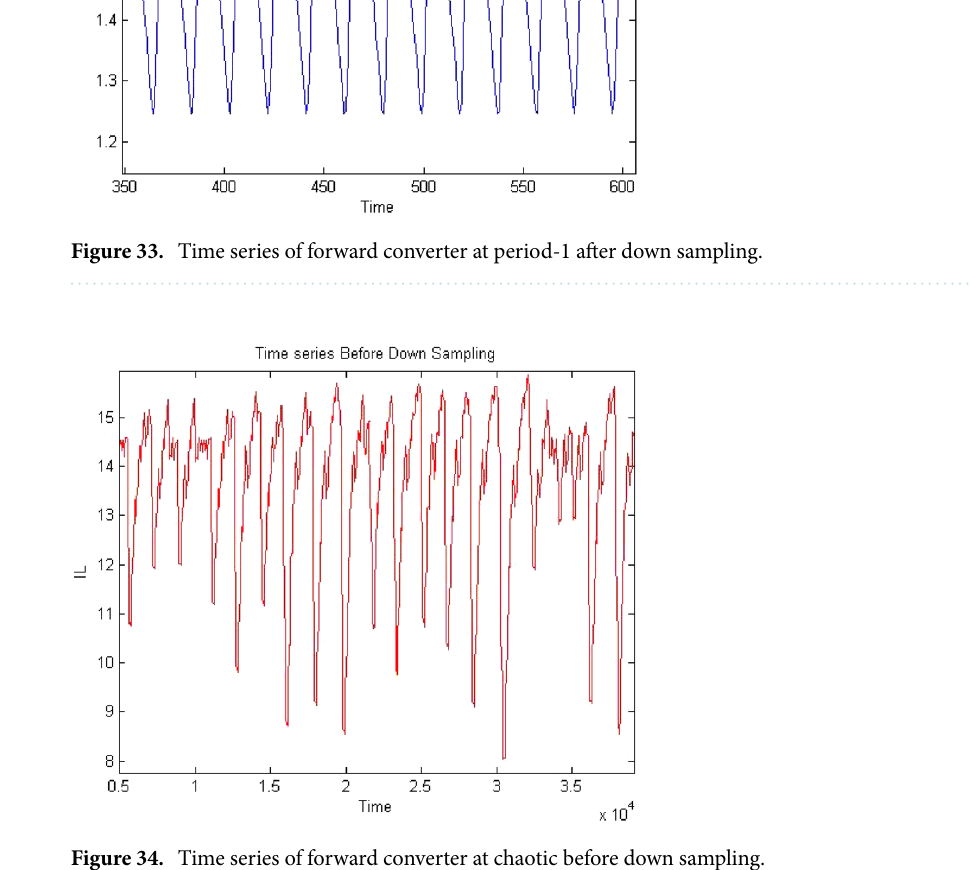
Figure 34. Time series of forward converter at chaotic before down